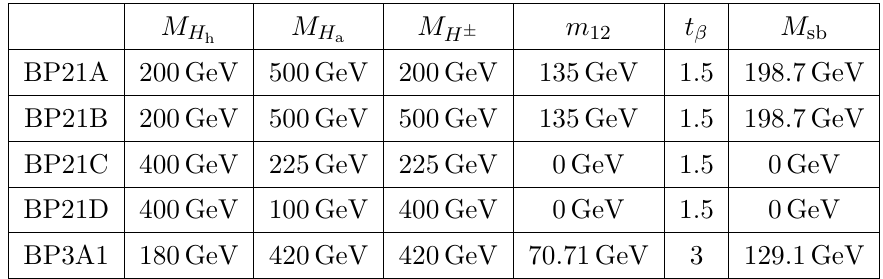
Table 1. 2HDM benchmark points in the alignment limit, i.e. s ref. [92]. The parameter M sb depends on the other parameters and is given for convenience.